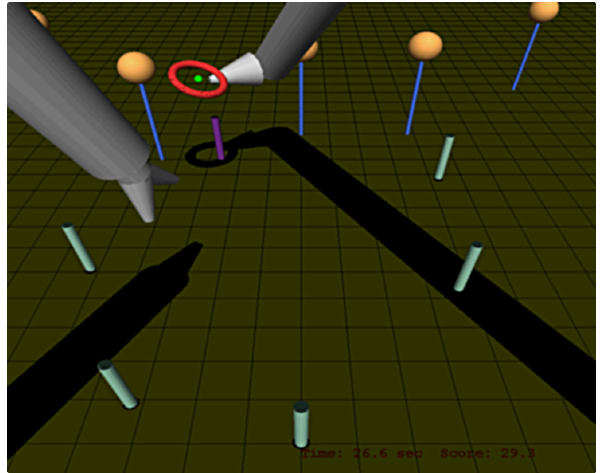
Figure 3. Screen capture of the VR simulator pick-and-place task.